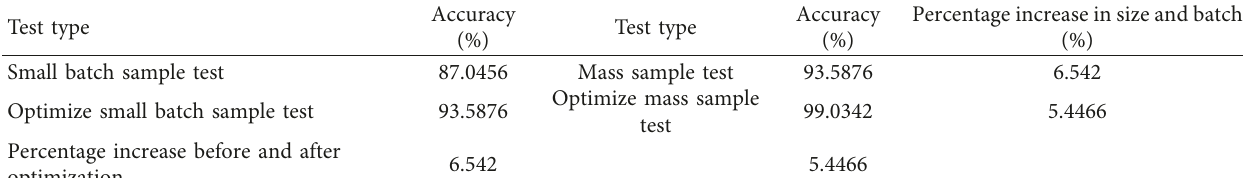
Table 2: Summary of test types and accuracy.